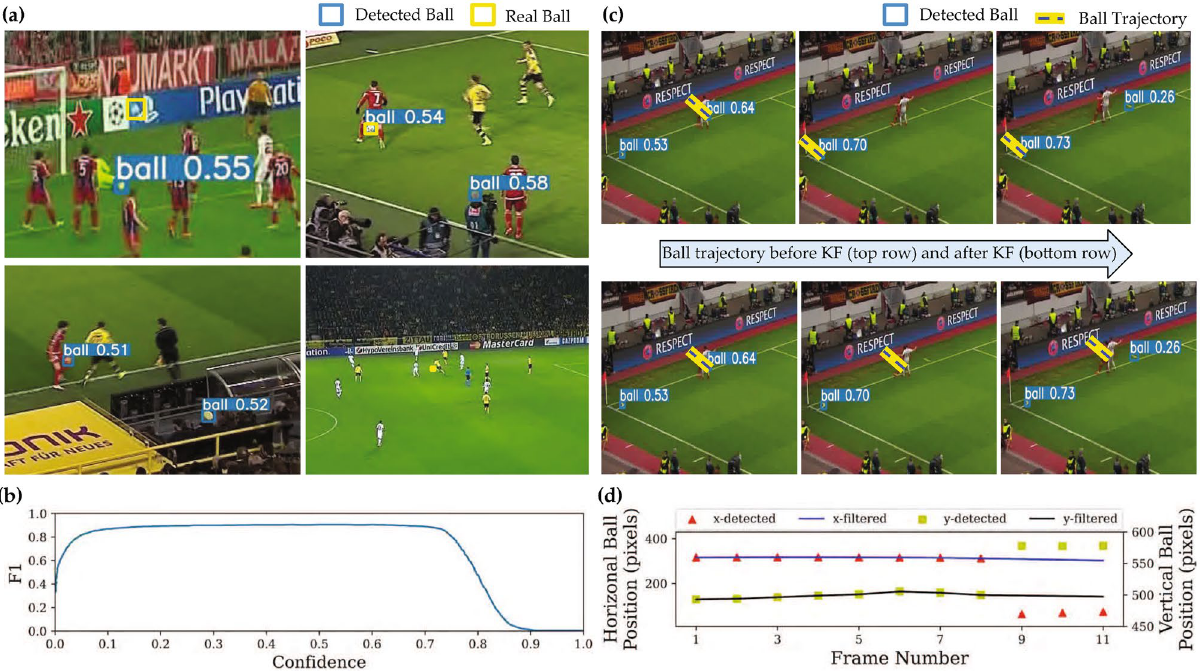
Figure 2. Performance of the ball detection network and ball tracking. ( a ) Ball detection failed in some cases when the ball was occluded by a player, moving on a non-green background, or had very small size (only few pixels). ( b ) F1 score-confidence curve shows the balance between the sensitivity and precision of ball detection when the confidence threshold is varied. ( c ) In frames 8–10 of the segment, the ball is occluded by the players in frames 9 and 10 and remains undetected while other outliers are present in each frame. KF rejects the outliers and uses its prediction to correctly estimate the location of the ball. ( d ) Horizontal and vertical coordinates of the detected and filtered ball location are shown. KF estimates a smooth track for the ball movement by rejecting the